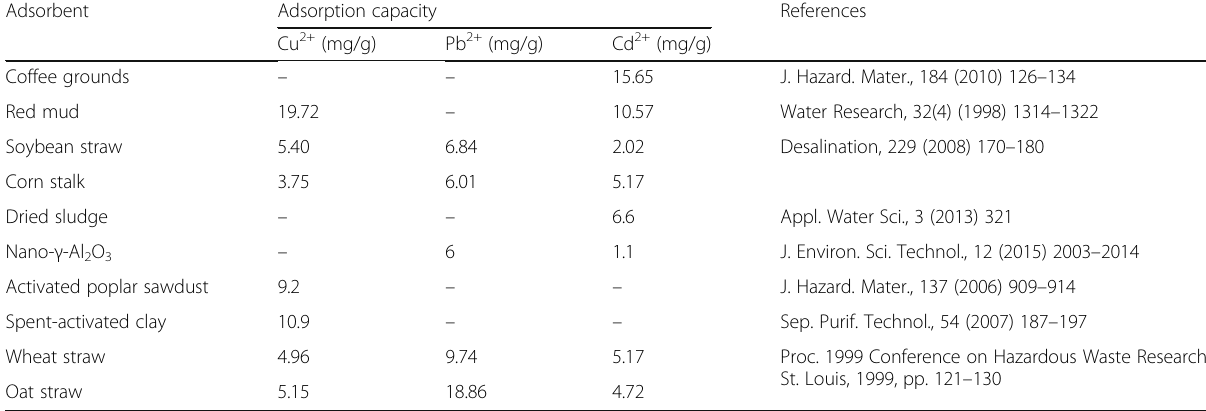
Table 2 Comparison of Cu 2+ , Pb 2+ , and Cd 2+ sorption capacities with other sorbents Adsorbent